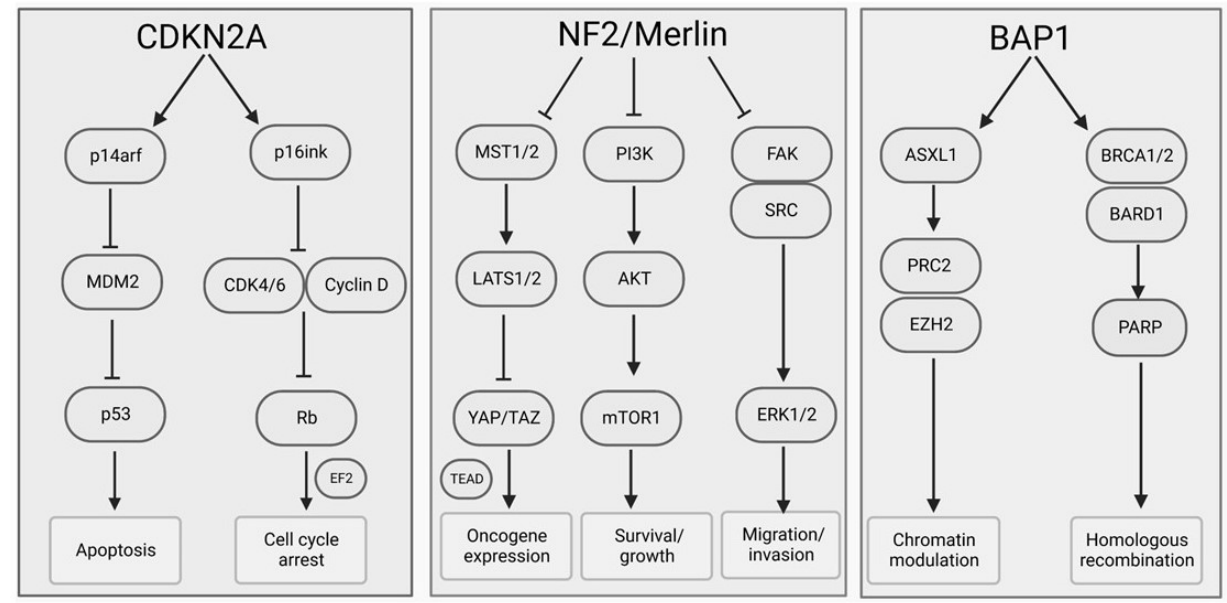
Figure 1. Schematic representation of most frequent tumor suppressor gene pathways related to targeted therapy in mesothelioma. Adapted with permission [43] and created with BioRender.com.